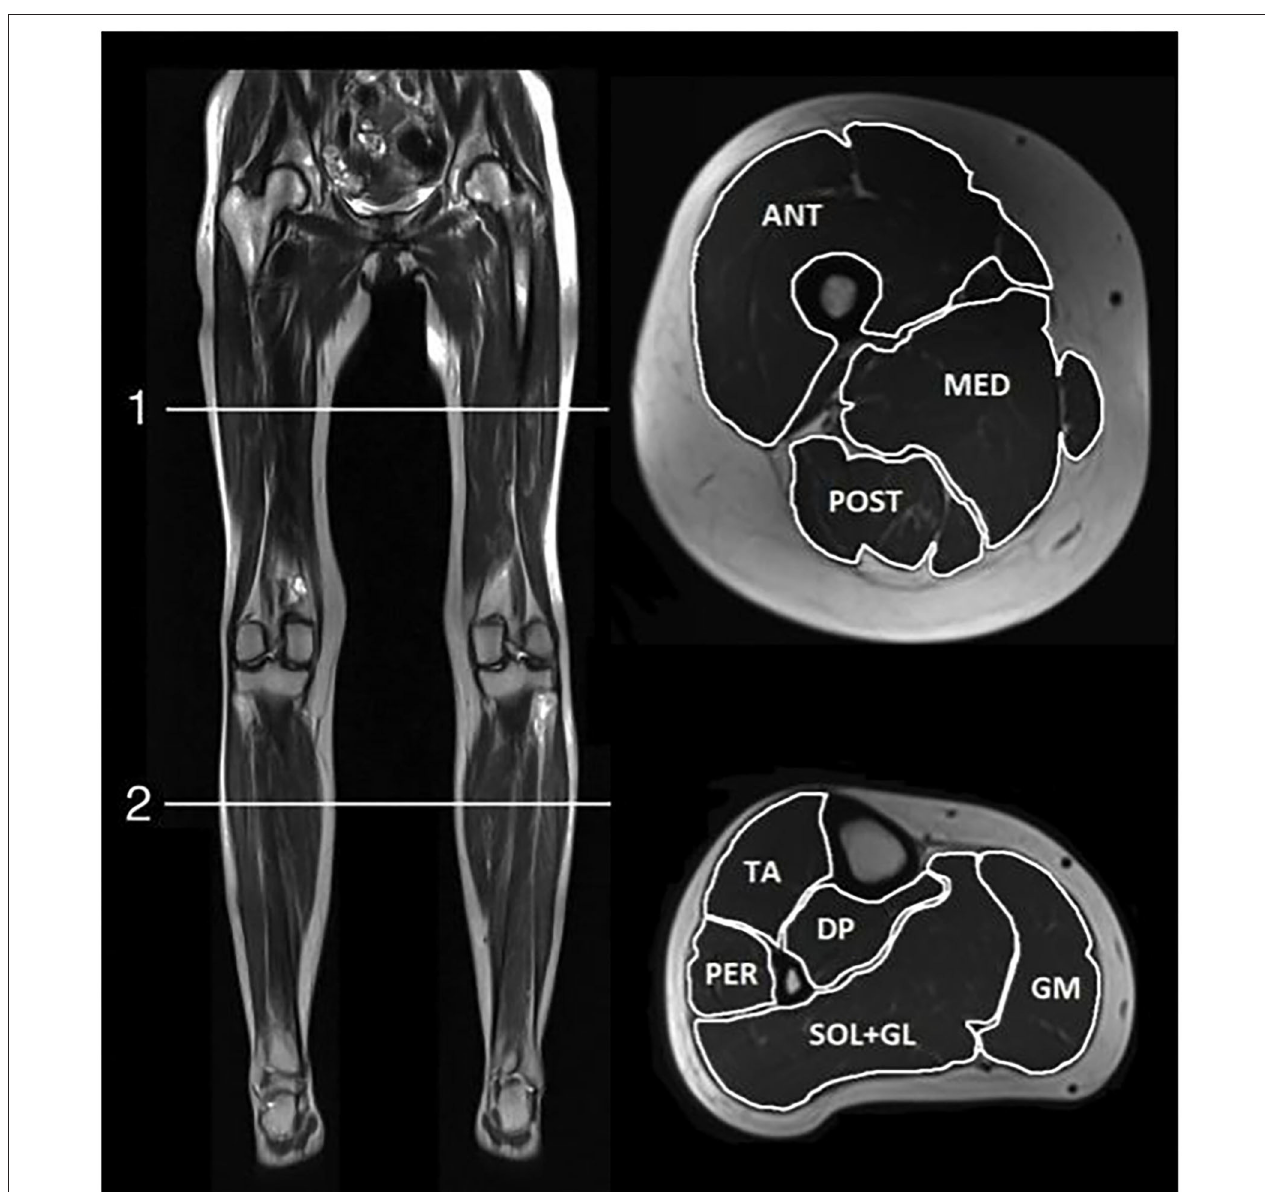
FIGURE 1 | MRI scan positions. T1-weighted MRI images of scan positions (left) and muscle groups outlined in cross sections of thigh (top right) and lower leg (bottom right). ANT, anterior thigh muscle compartment; MED, medial thigh muscle compartment; POST, posterior thigh muscle compartment; AC, anterior calf muscle compartment; PER, peroneal muscles; DP, deep posterior calf muscle compartment; SOL + GL, soleus and lateral gastrocnemius muscles; GM, medial gastrocnemius muscle.